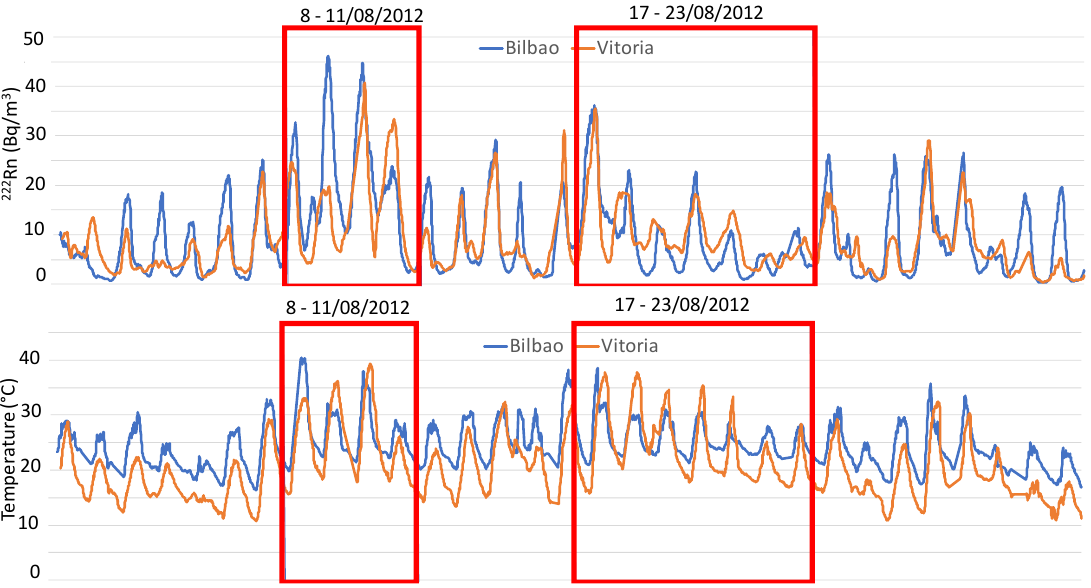
Figure 7. Ten-minute radon activity concentrations during August 2012 in Bilbao and Vitoria.